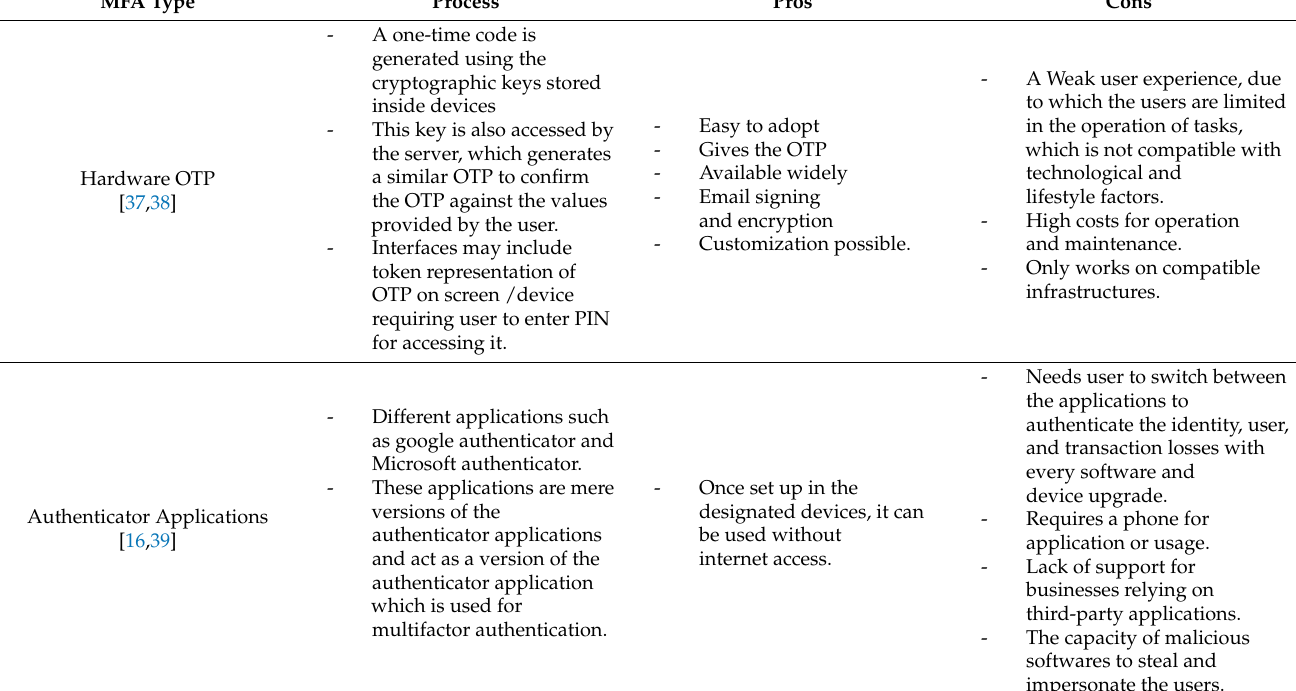
Table 3. Various Types of MFA and its Pros and